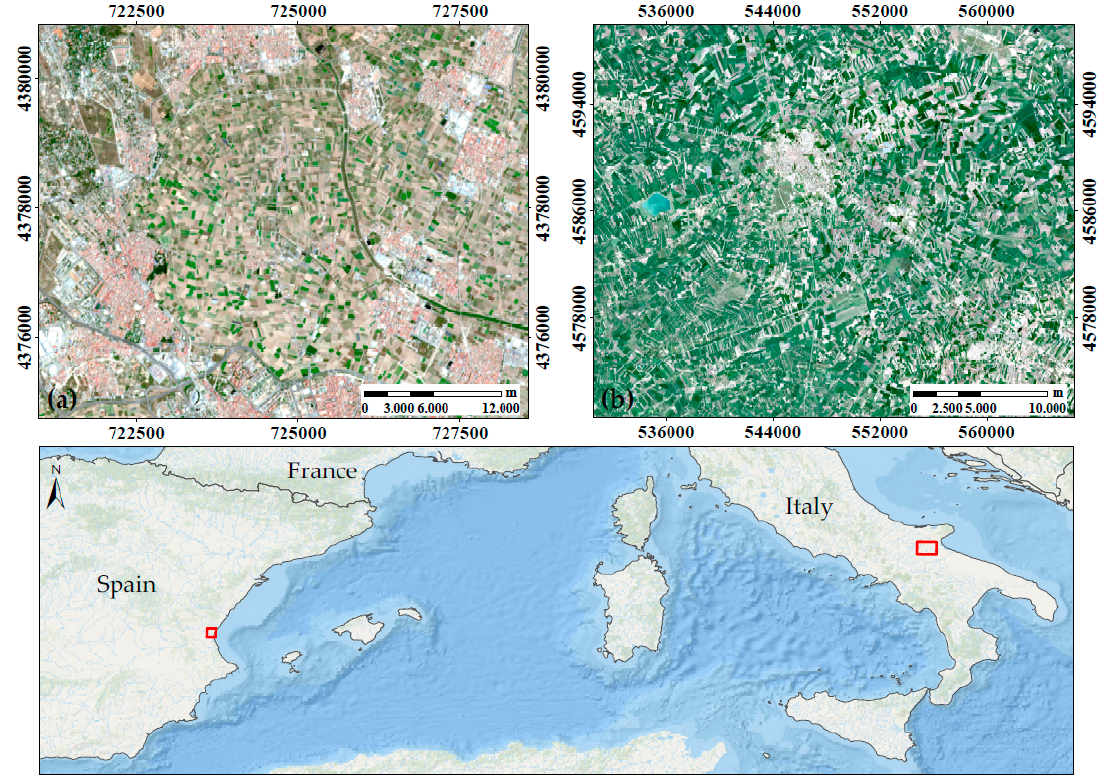
Figure 1. Test site locations. (a) Valencia (Spain) from the Sentinel-2 image of 6 April 2017, UTM-WGS84 Zone 30S (b) Foggia (Italy) from the Sentinel-2 image of 8 April 2017, UTM-WGS84 Zone 33T.